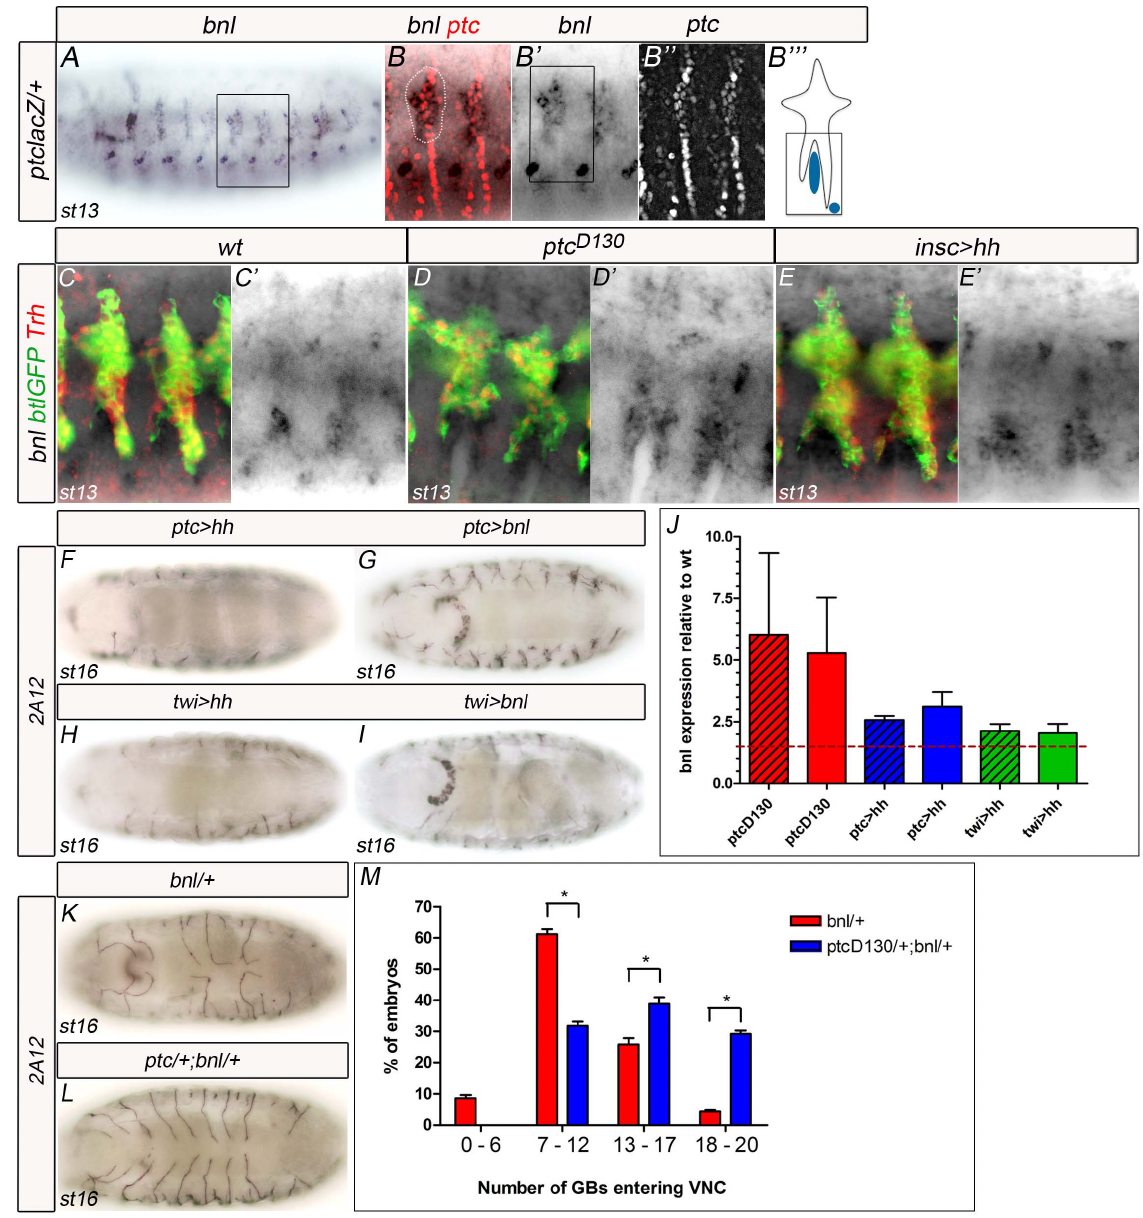
Figure 6. The Hh pathway modulates Bnl expression. (A,B) bnl expression in a ptclacZ heterozygous stage 13 embryo also stained with lacZ. (B) Marked area contains ptc -expressing cells that co-express bnl in cells surrounding the migrating GBs. (B 9 ) Only in situ bnl expression; Rectangle marks the are depicted in panel B 999 for clarity. (B 0 ) Only ptclacZ expression. (B 999 ) Schematic representation of the main areas of bnl expression surrounding LTa and LTp/GB. (C–E) bnl expression in wt (C), ptc (D) and in embryos expressing Hh in the VNC (E), in stage 13 embryos co-stained with anti-GFP and anti-Trh to mark all tracheal cells. C 9 , D 9 and F 9 show only the bnl in situ hybridisation pattern. (F–I) Ventral views of stage 16 embryos stained with 2A12 to visualise the tracheal lumen. (J) Graphic representation of quantitative Real-Time PCR results. The two columns with the same colour represent independent experiments using the same genotype. Hashed red line marks 1.5-fold expression. All overexpression experiments induce greater levels of bnl expression than those in wt. P-values # 0.01. (K,L) Ventral views of stage 16 embryos stained with 2A12 to visualise the tracheal lumen. (M) Quantification of the number of GBs entering the VNC in embryos heterozygous for bnl (red) in comparison with embryos transheterozygous for ptc and bnl (blue) *P-values #